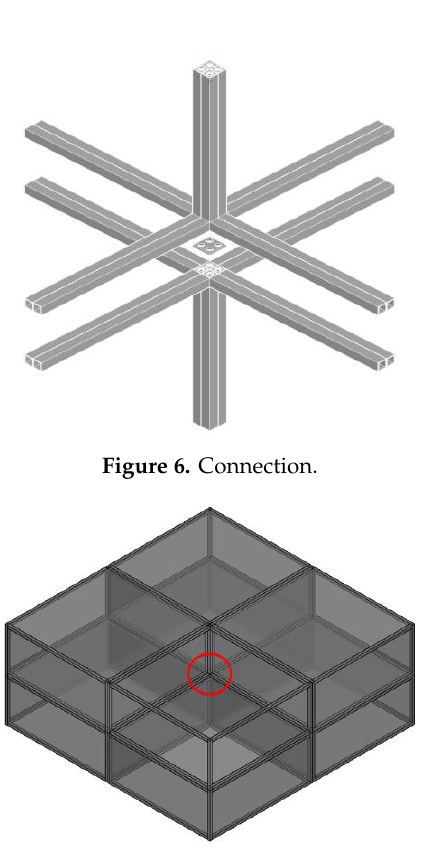
Figure 7. Connection in the modular building.